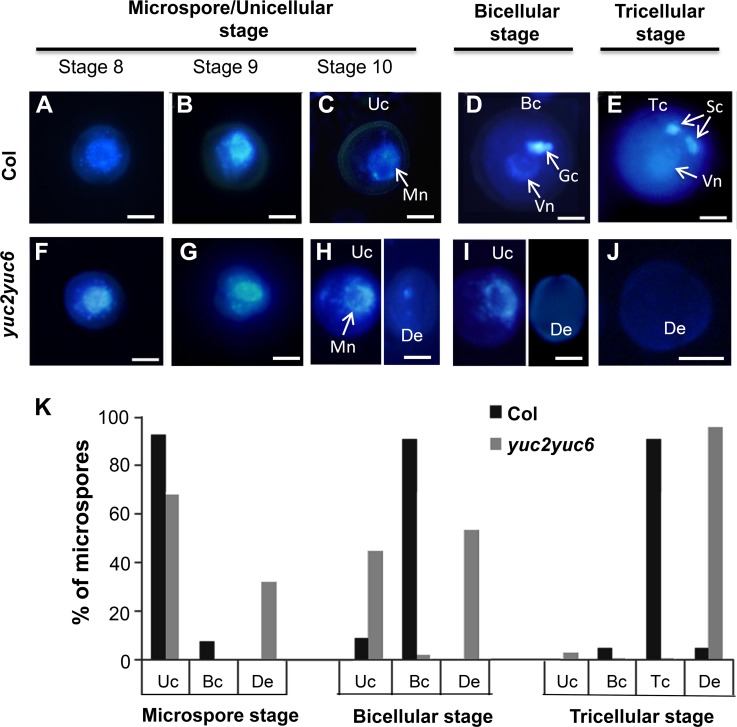
The early stages of male gametogenesis were defective in the yuc2yuc6 double mutants.(A-J) DAPI staining of pollens from wild type (A-E) and yuc2yuc6 (F-J) at different developmental stages. Microspores from anthers at (A and F) stage 8; (B and G) stage 9; (C and H) stage 10 were shown. Some of the yuc2yuc6 microspores were degenerated and had little DAPI staining (H right). (D and I) pollens at the bicellular stage. Note that the nuclei of yuc2yuc6 were arrested at the unicellular state or degenerated and could not form two nuclei as in the wild type (I). (E and J) Pollen at the tricellular stage. The yuc2yuc6 pollen grains lacked genomic DNA (J) while WT pollen showed strong DAPI staining (E). (K) Quantitative analysis and comparison of pollen defects between wild type and yuc2yuc6 (n>600 for each stage). Uc, Unicellular pollen; Mn, microspore nucleus; Gc, generative cell; Vn, vegetative nucleus; Sc, sperm cell. Bc, Bicellular pollen; Tc, Tricellular pollen; De, Degenerated pollen. Bars = 5 μm.